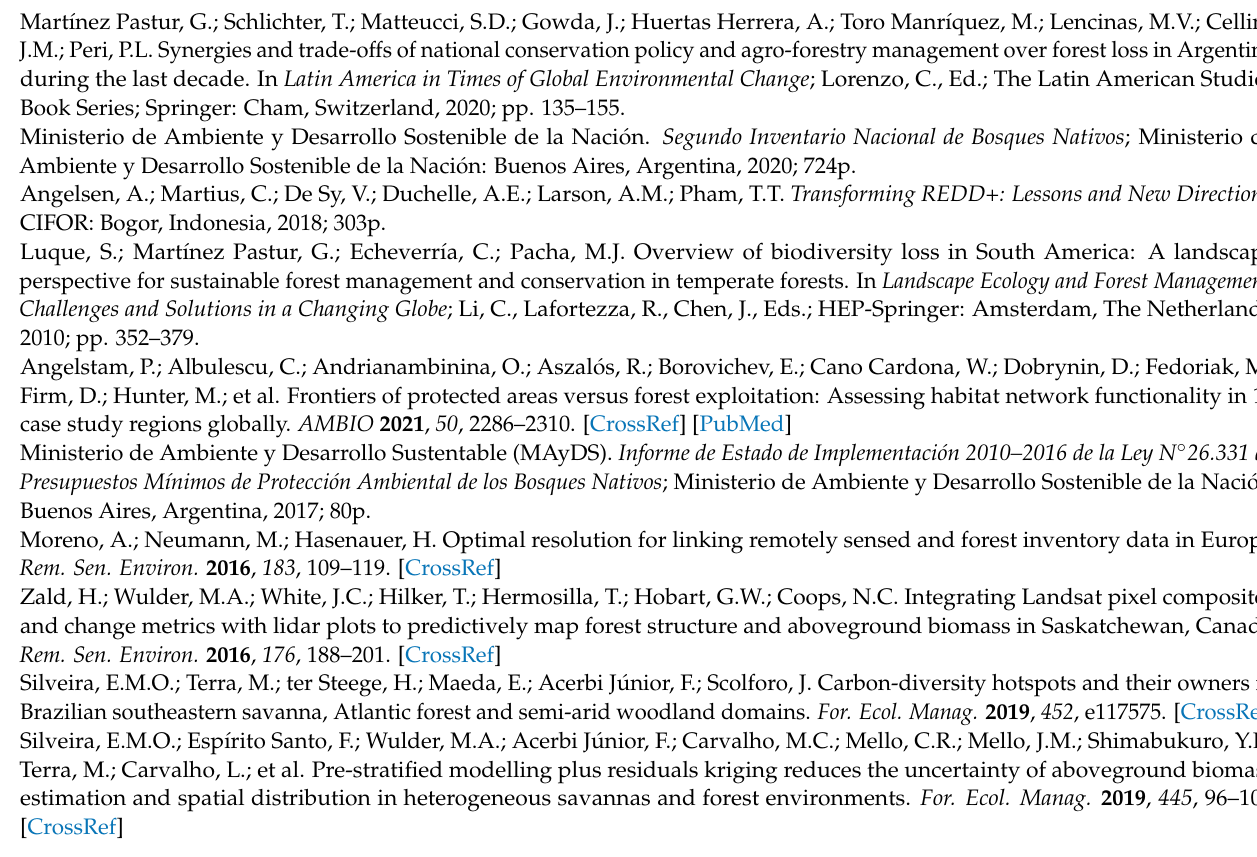
Figure A4. Soil organic carbon content (SOC) of the Patagonian forests in Argentina, classified by degrees of latitude and longitude, mean annual temperature ( ◦ C), mean rainfall (mm yr − 1 ) and elevation (m a.s.l.). Bars indicate standard